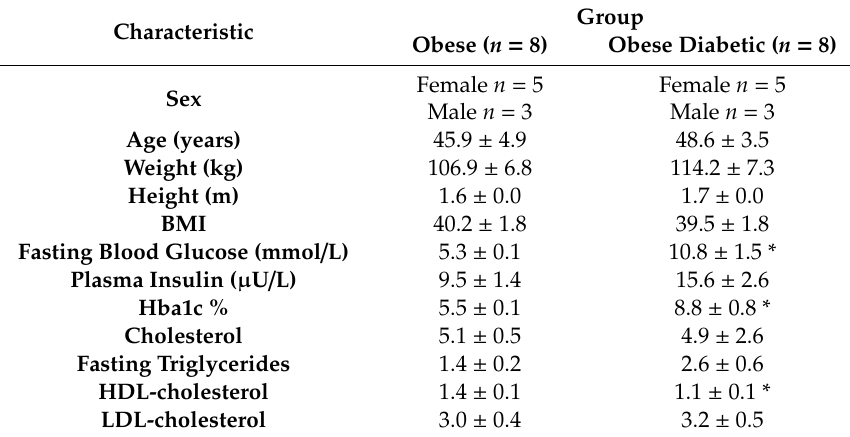
Table 1. Characteristics for donors of rectus abdominus skeletal